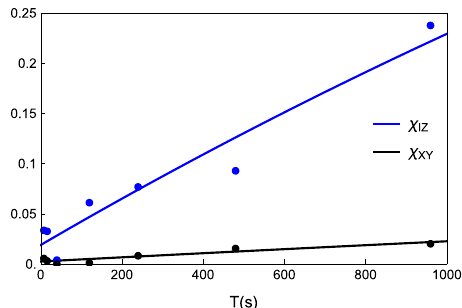
Fig. 8 Fitting of process matrix elements evolution. Blue and black points are experimental results of χ IZ and χ XY , respectively. The solid lines are their fi tting results.